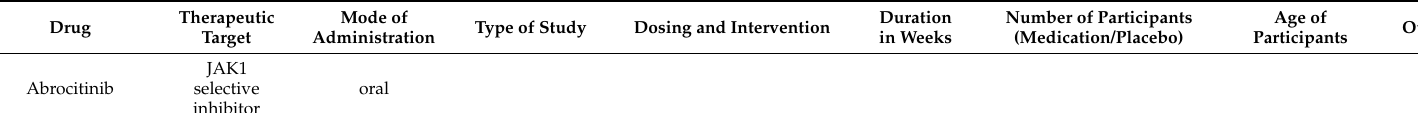
Table 2. Summary of new atopic dermatitis treatments’ effectiveness in reducing